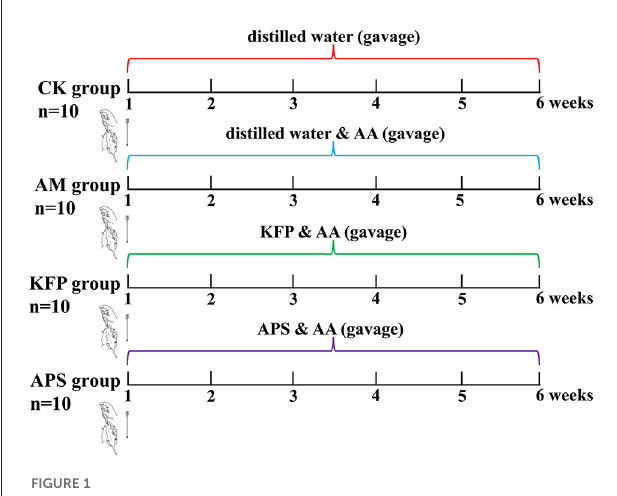
FIGURE1 Animal experimental